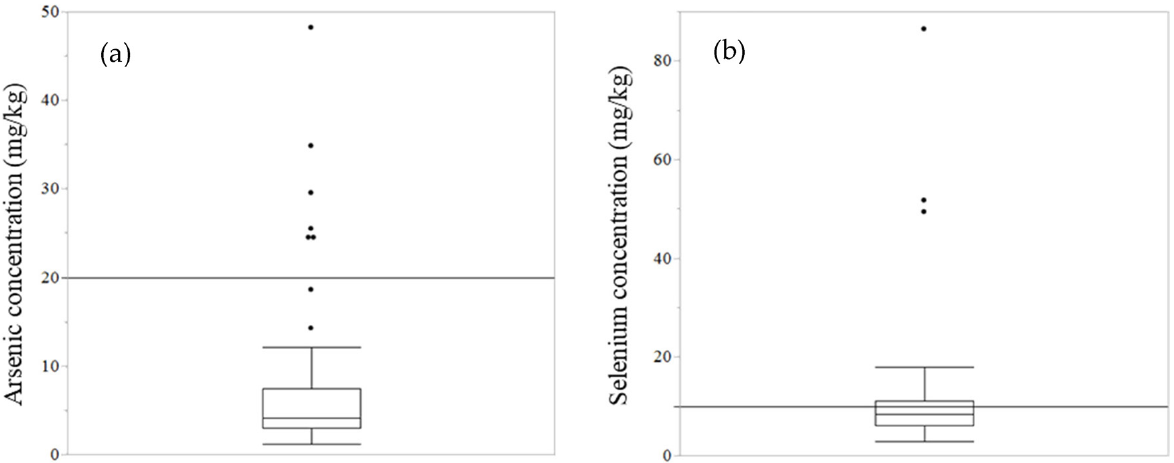
Figure 2. Arsenic and selenium concentration in soil (all samples in this study). Arsenic ( a ) and selenium ( b ) concentration in all soil samples are shown in a box plot. The black line shows the maximum allowable limit, as regulated in Mongolia (arsenic: 20 mg/kg soil, selenium: 10 mg/kg soil). Blood metal concentration is described in Table 2. Strong species differences were not observed for many metals in the same area. However, the camel accumulated a slightly higher concentration of zinc than the other animals in all areas. The median concentration of zinc in Dornogovi UB was 50.4 mg/kg (dry weight) in camels’ blood, while